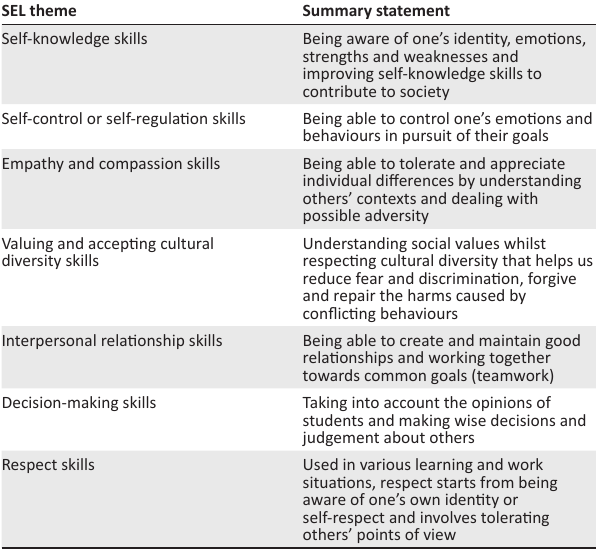
TABLE 1: Summary statements of seven common social emotional learning